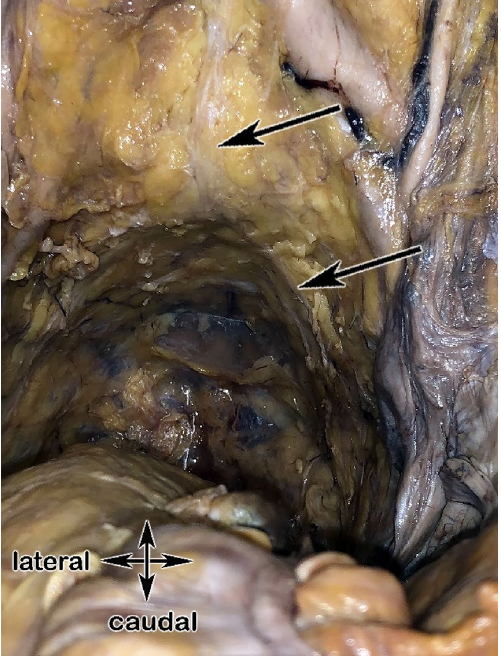
Figure 10. Dissected hemipelvis of a body donor to science showing the electrode placed on the bladder cranially (upper black arrow), inferior hypogastric plexus shown with the lower black arrow.